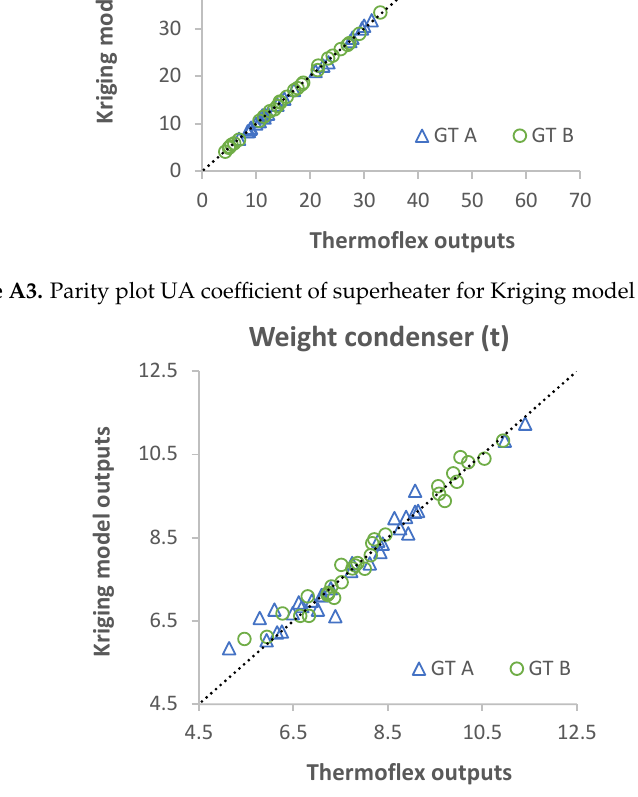
Figure A4. Parity plot of the weight of the condenser for Kriging model validation.